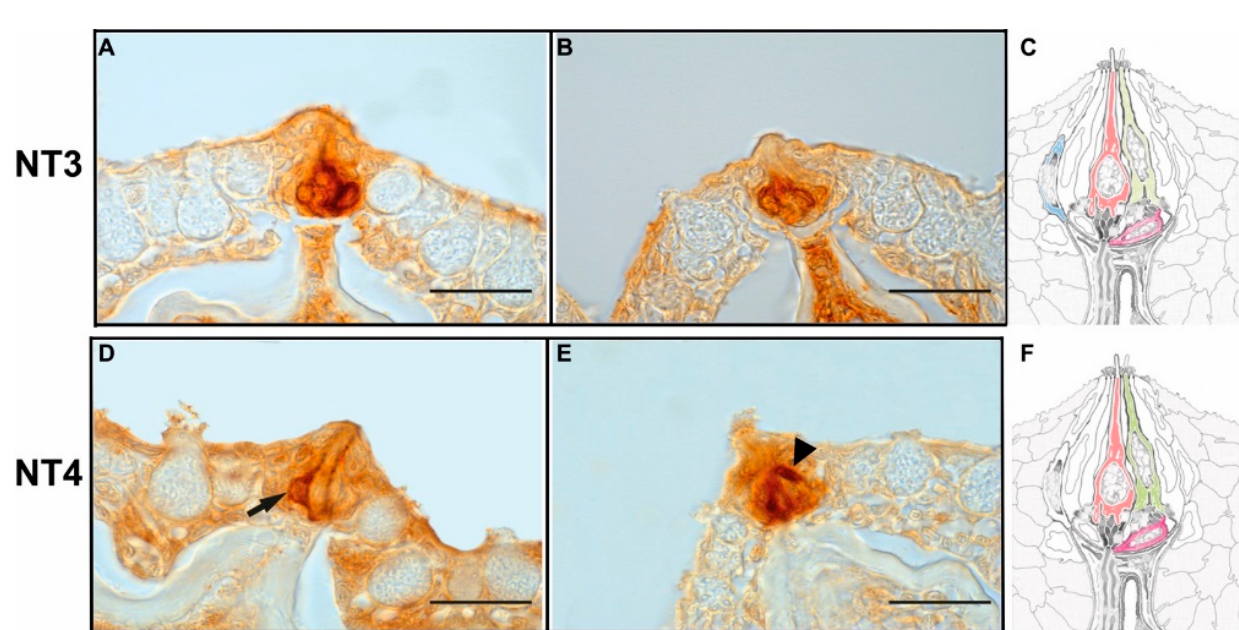
Figure 3. ( A , B ) NT3 and ( D , E ) NT4 positive cells. ( C , F ) Taste bud scheme showing hypothetic congruence of positive cells with ultrastructural classification. The arrow indicates a putative light cell, while the arrowhead indicates a dark cell. Refer to color code in Figure 1 to recognize the cell type. Scale bar = 20 µm.